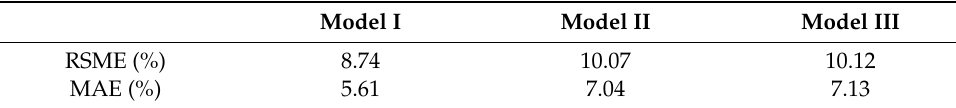
Figure 11. Results of wind power prediction. Table 3. Prediction error of